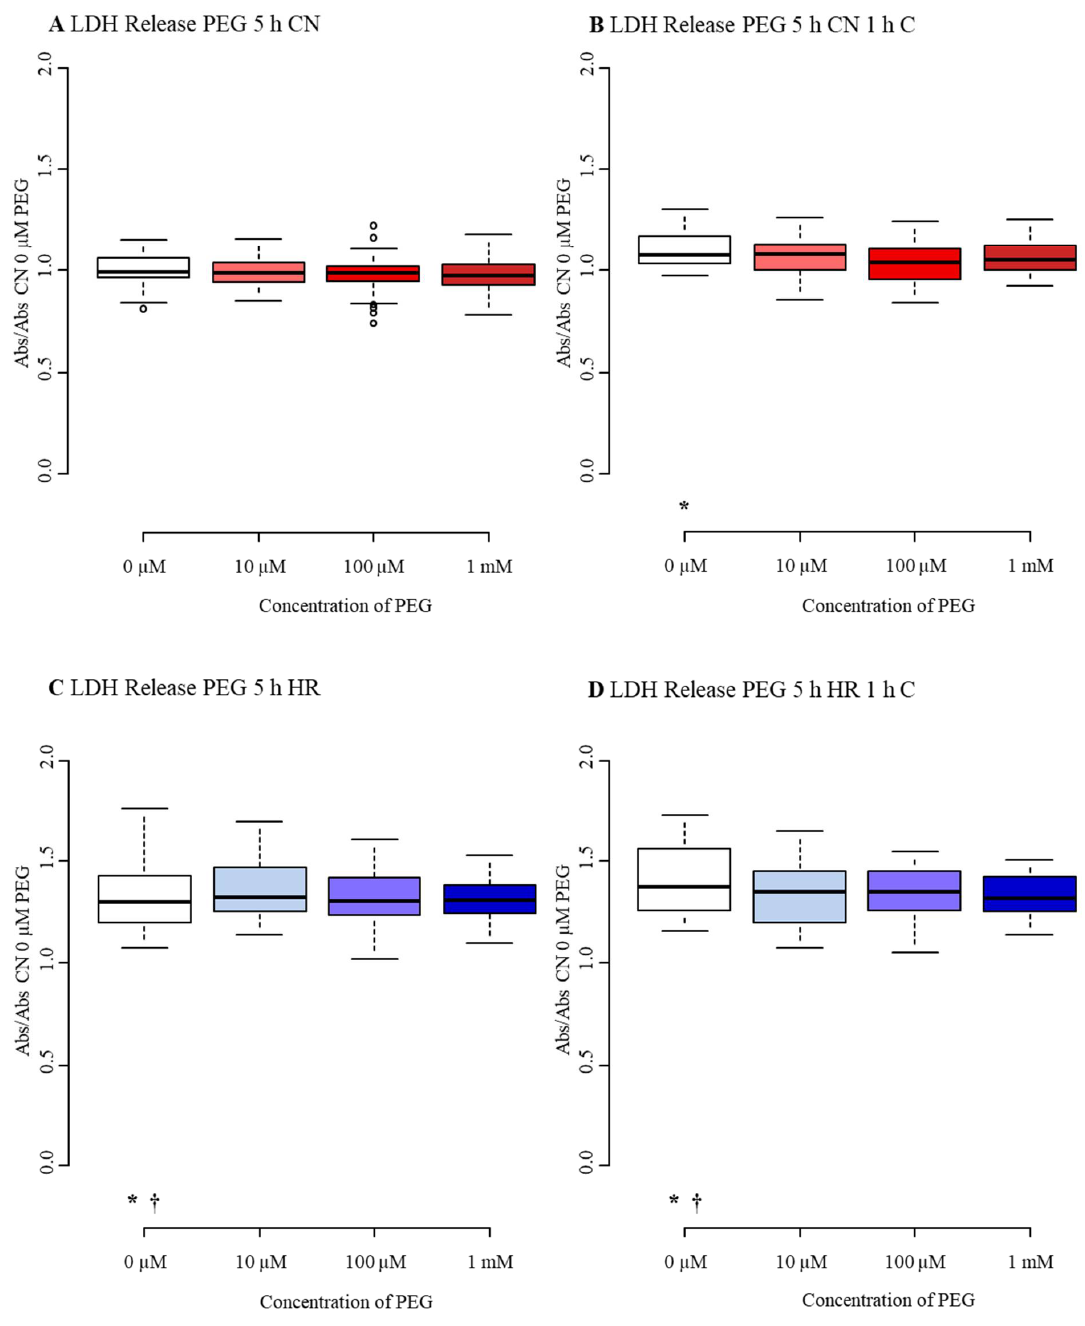
Figure A5. Cytotoxicity/membrane damage after 5 h injury and treatment with 0 µ M, 10 µ M, 100 µ M, and 1 mM of PEG. ( A ) normoxia (CN-C); ( B ) normoxia and 1 h compression (CN+C); ( C ) hypoxia (HR-C); ( D ) hypoxia and 1 h compression (HR+C). Data visualized as boxplots (median, 25th, 75th percentile, whiskers: minimum, maximum, dots: potential outliers); p < 0.05; n = 6–7 experiments/group. Significances between different concentrations of P188 are displayed as brackets, significances between ( A – D ) for 0 µ M P188 are represented by symbols (* vs. CN-C 0 µ M P188, † vs. CN+C 0 µ